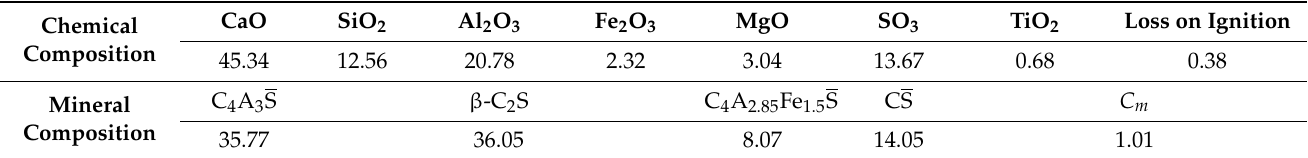
Table 1. Chemical compositions and mineral compositions of HBSAC (%).